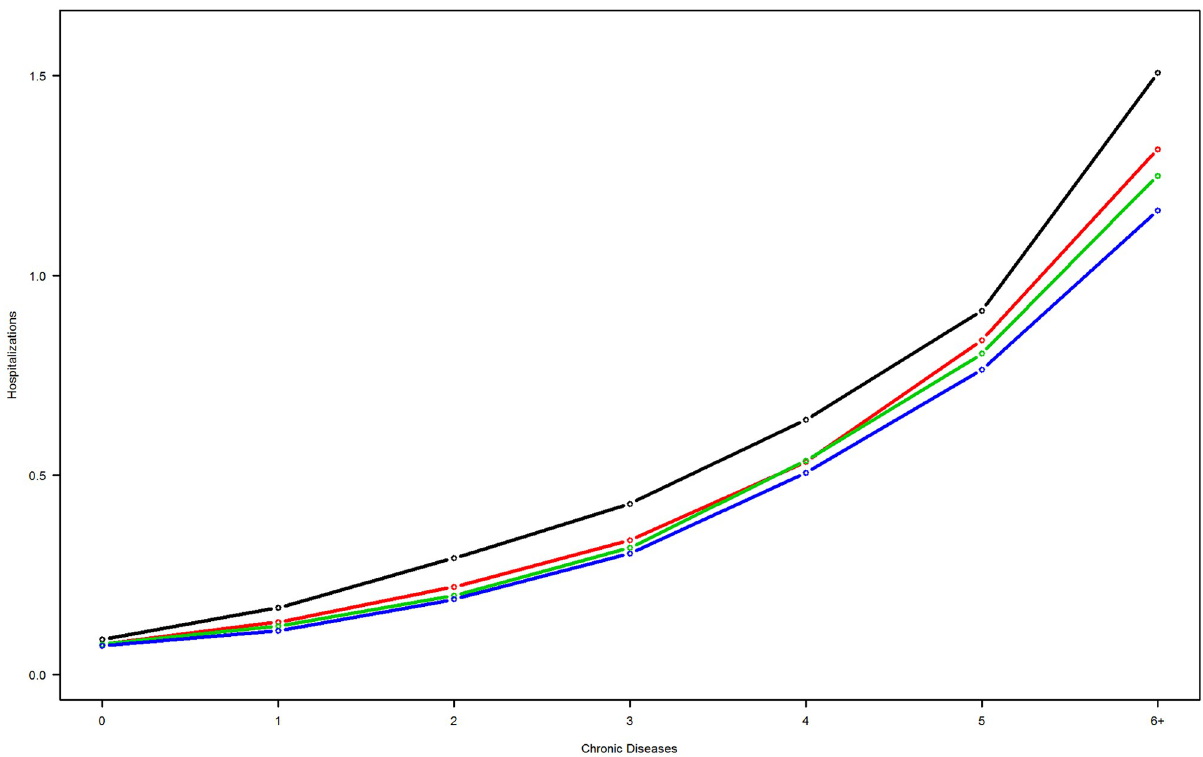
Fig 2. Number of chronic conditions associated with the modeled rate of hospitalizations by educational attainment levels. Black line, no education; red line, short education; green line, medium education; blue line, long education.